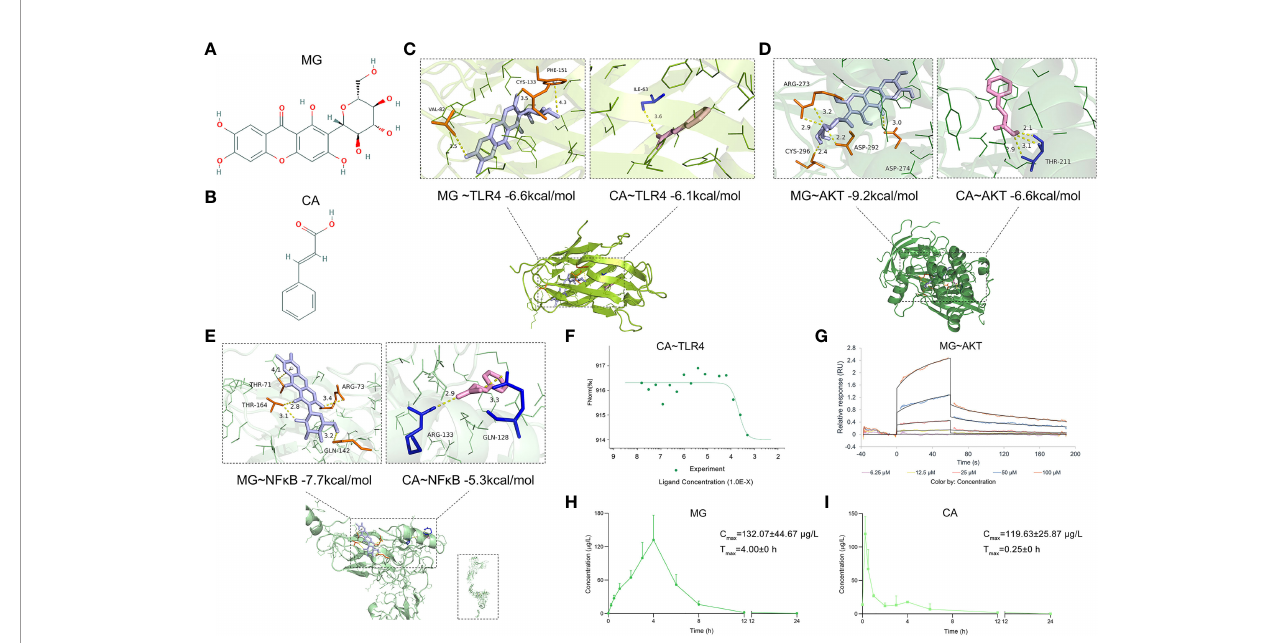
FIGURE 2 | Chemical structures of MG and CA, molecular docking simulation of the binding patterns of them with corresponding proteins, as well as the mean plasma concentration – time curves of MG and CA after the treatment of BHGZD. (A) Chemical structure of MG (obtained from PubChem databases, CID 5281647). (B) Chemical structure of CA (obtained from PubChem databases, CID 444539). (C) Molecular docking simulation of the binding patterns of TLR4 with MG and CA, respectively. (D) Molecular docking simulation of the binding pattern of AKT with MG and CA, respectively. (E) Molecular docking simulation of the binding pattern of NF k B with MG and CA, respectively. (F) Microscale thermophoresis (MST)-determined binding af fi nity between CA and TLR4 protein. (G) Surface plasmon resonance (SPR) assay of the interaction between MG and AKT1 protein. (H) The mean plasma concentration – time curves of MG after the treatment of BHGZD for 12 days at the dosage of 21.4 g/kg each day ( n = 3 per group). (I) The mean plasma concentration – time curves of CA after the treatment of BHGZD for 12 days at the dosage of 21.4 g/kg each day ( n = 3 per